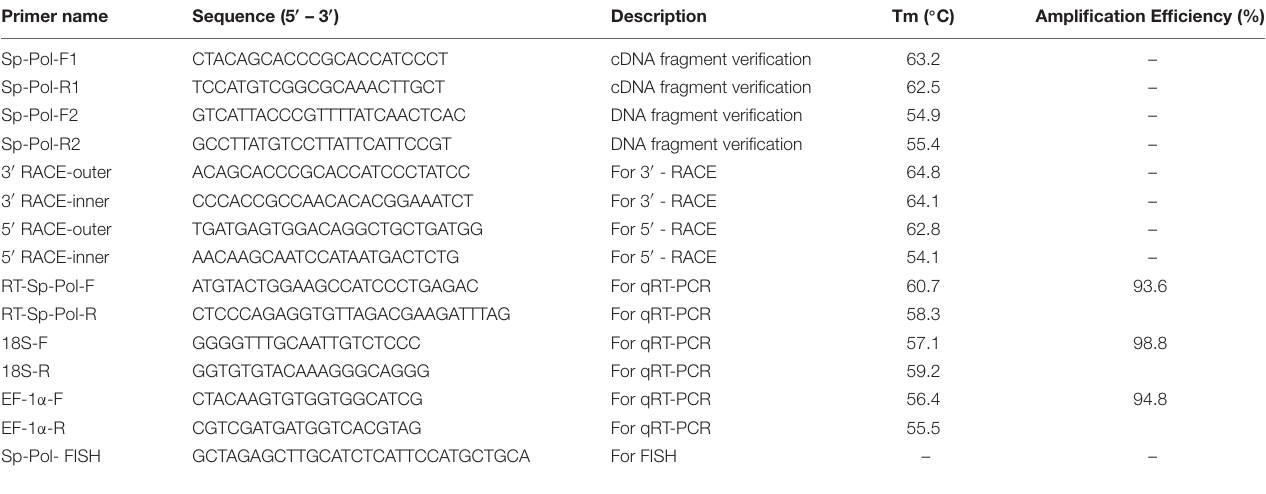
TABLE 1 | Primers used for fragment verification, 3 (cid:48) /5 (cid:48) – RACE, qRT-PCR, FISH, and RNAi of Sp-Pol